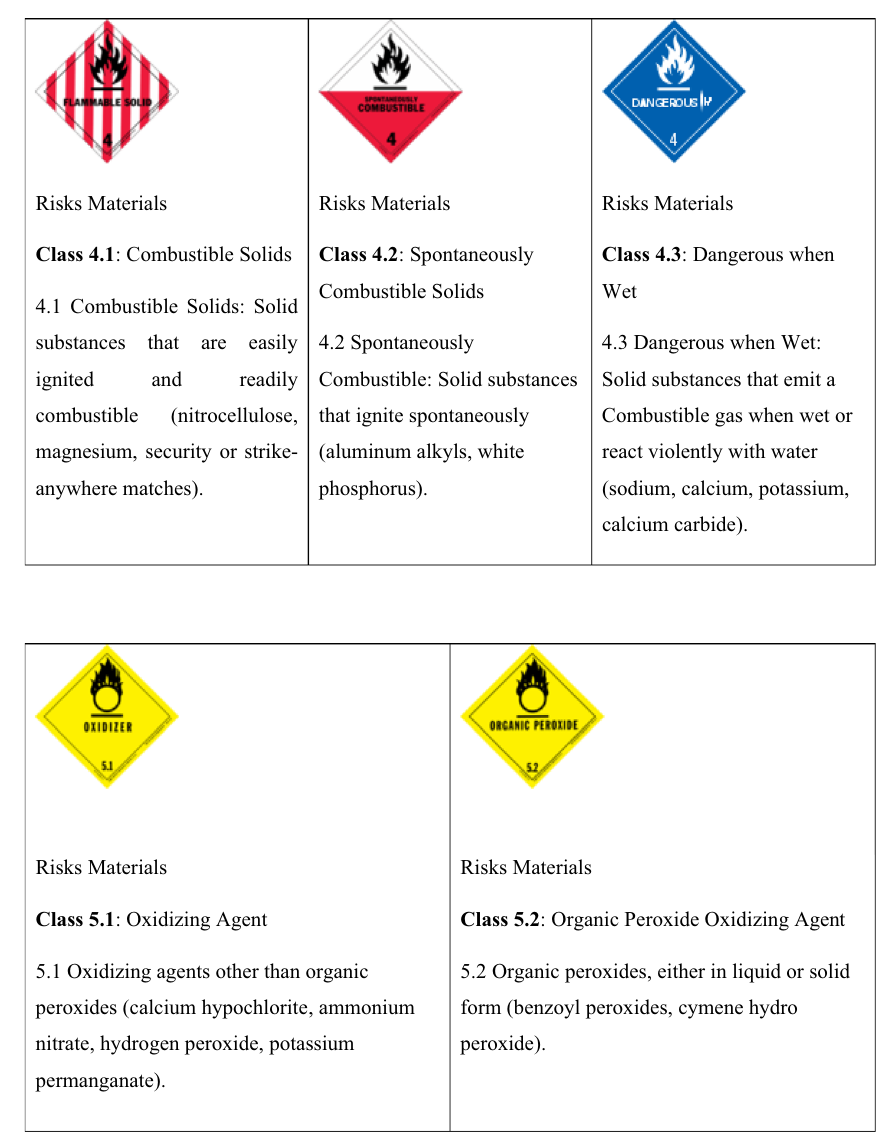
Fig. 4 Class 4, Combustible